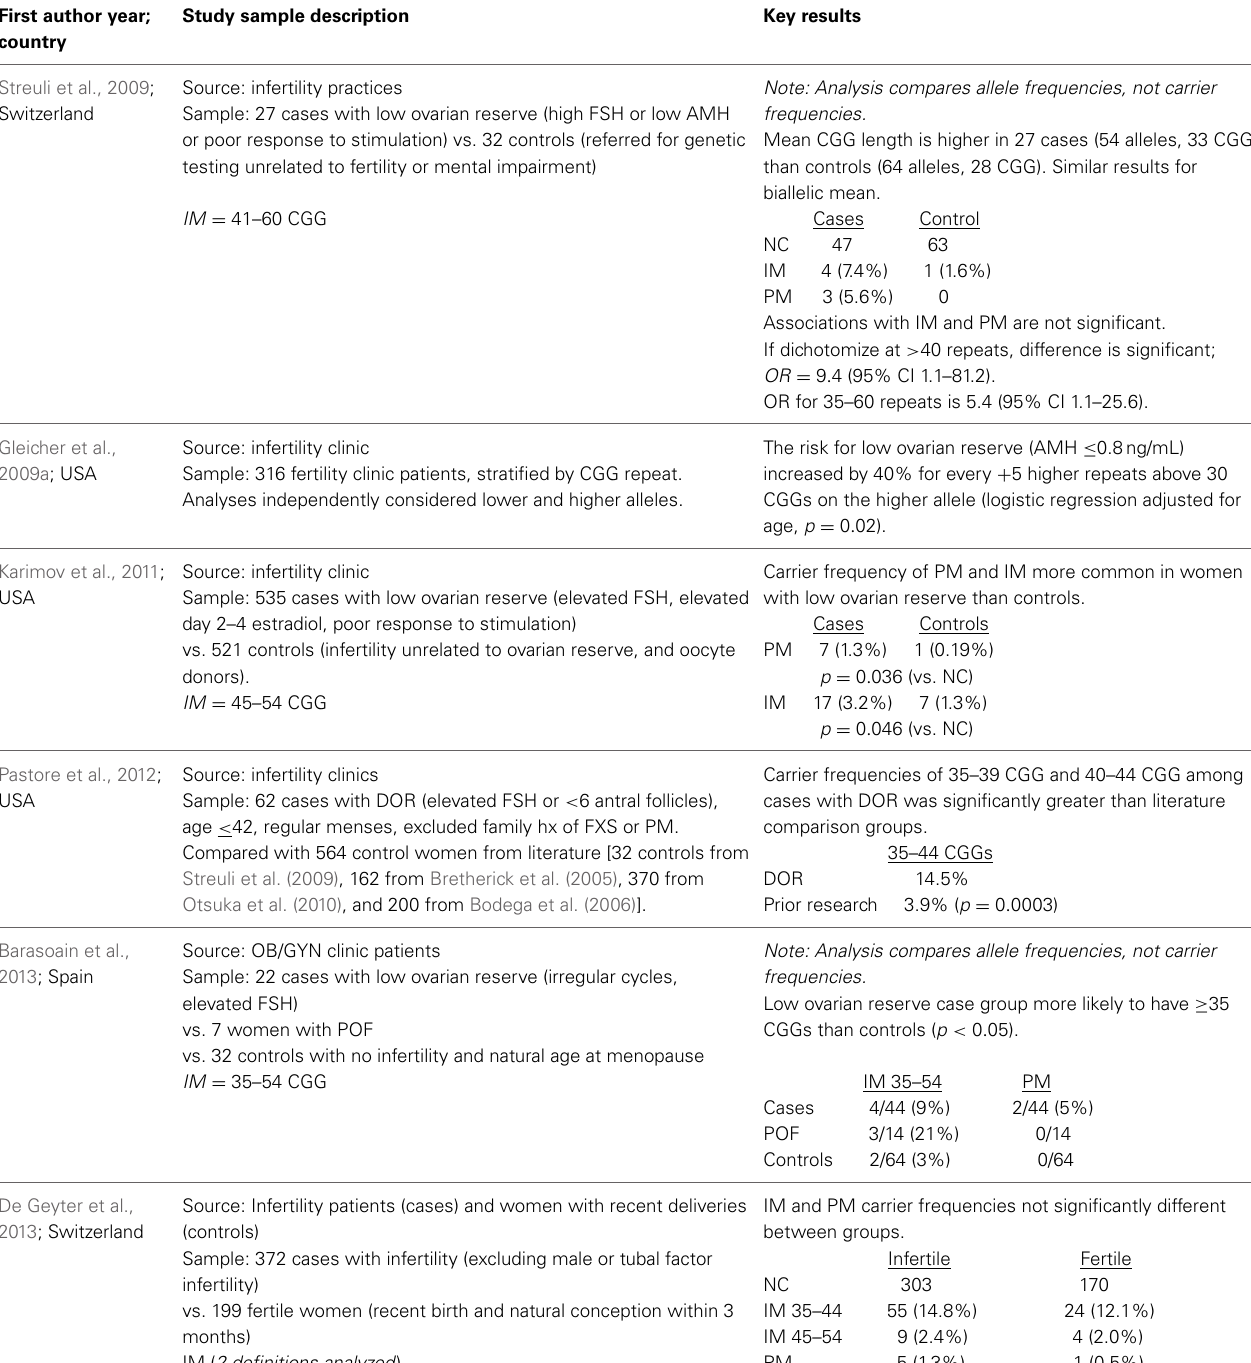
Table 1 | Literature summary on FMR1 CGG repeat length among women diagnosed with fertility delays due to ovarian reserve issues, sorted by